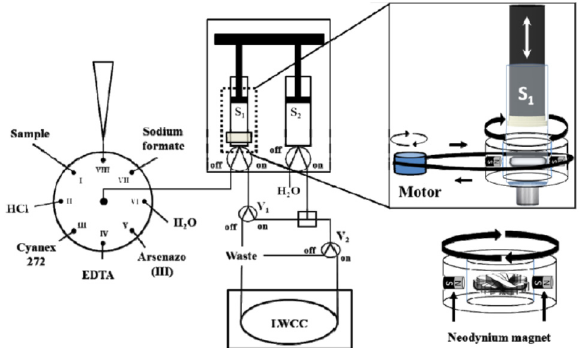
Figure 3. Schematic depiction of a flow system incorporating lab-in-syringe liquid–liquid microextraction (LIS-LLME) with magnetic stirring assistance (MSA) for radionuclide determination [47]. LWCC: liquid waveguide capillary cell, V: solenoid valve, S: syringe.